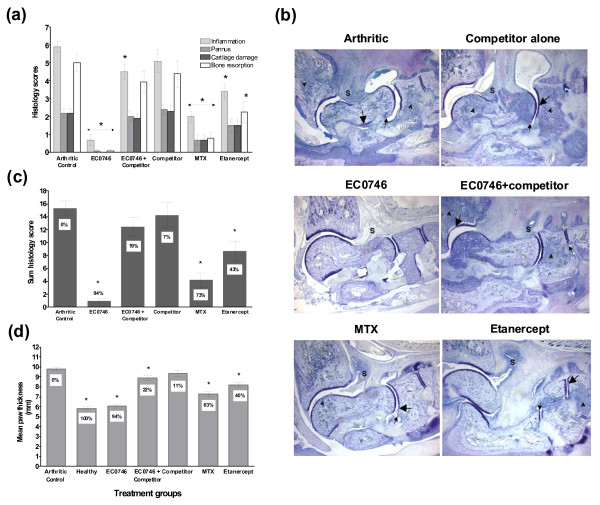
Histopathological assessment. The histopathological analysis was performed on formalin-fixed arthritic hind paws by Bolder BioPATH Inc. (Boulder, CO, USA). (a) Individual histological scores of ankle joints on a scale of 0 to 5 for inflammation, bone resorption, pannus formation, and cartilage damage with a maximal histology score of 20 per foot. (b) Representative photomicrographs (16x) of the ankle closest to the (c) mean summed histological score. (d) Dorsal to ventral paw thickness for each group. Notably, the arthritic control animal showed very severe inflammation (S), bone resorption (arrowhead) with mild pannus (small arrow), and cartilage damage (large arrow). *P < 0.05 when compared with the arthritic control group. MTX, methotrexate.